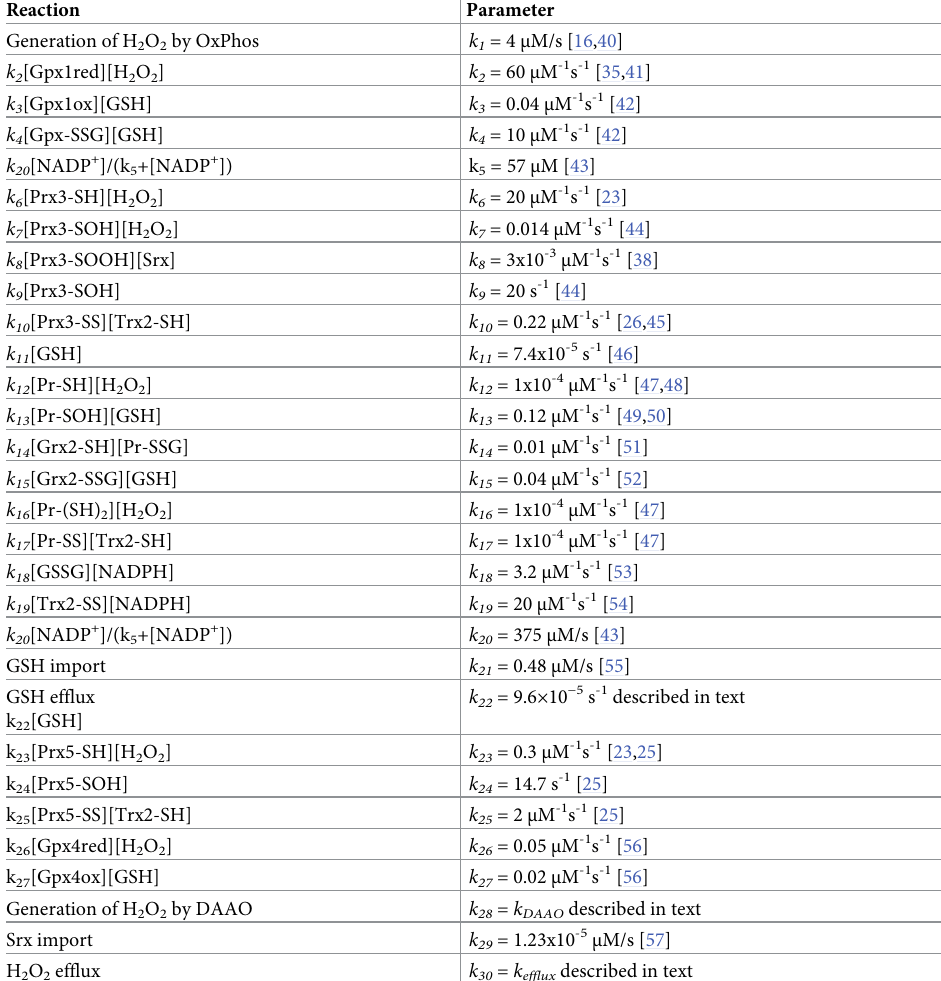
Table 1. Kinetic parameters. Calculations for parameters that were derived can be found in SI.